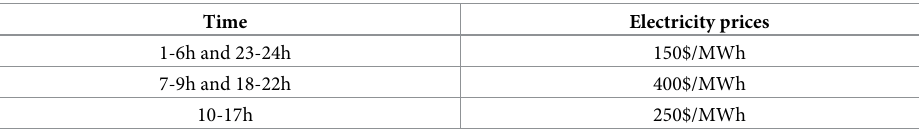
Table 1. Electricity prices of main